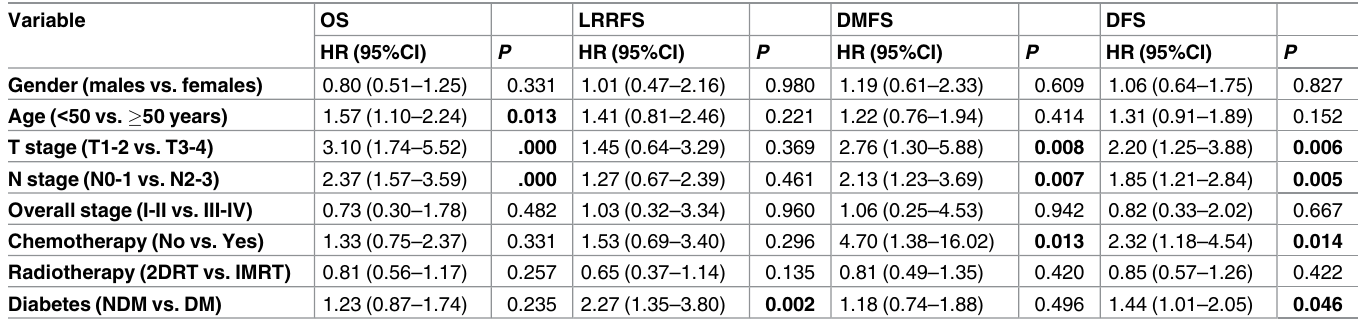
Table 5. Multivariate analysis of prognostic factors for the two groups of NPC patients.